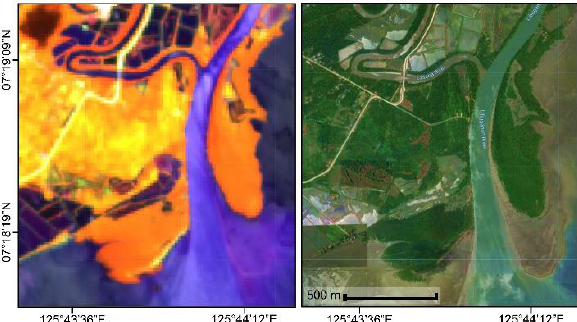
Figure 6 . Mangroves along Libuganon River in tile 51NYJ that are unaccounted for in the MVI-based 2019 Mangrove Extent Map of the Philippines.